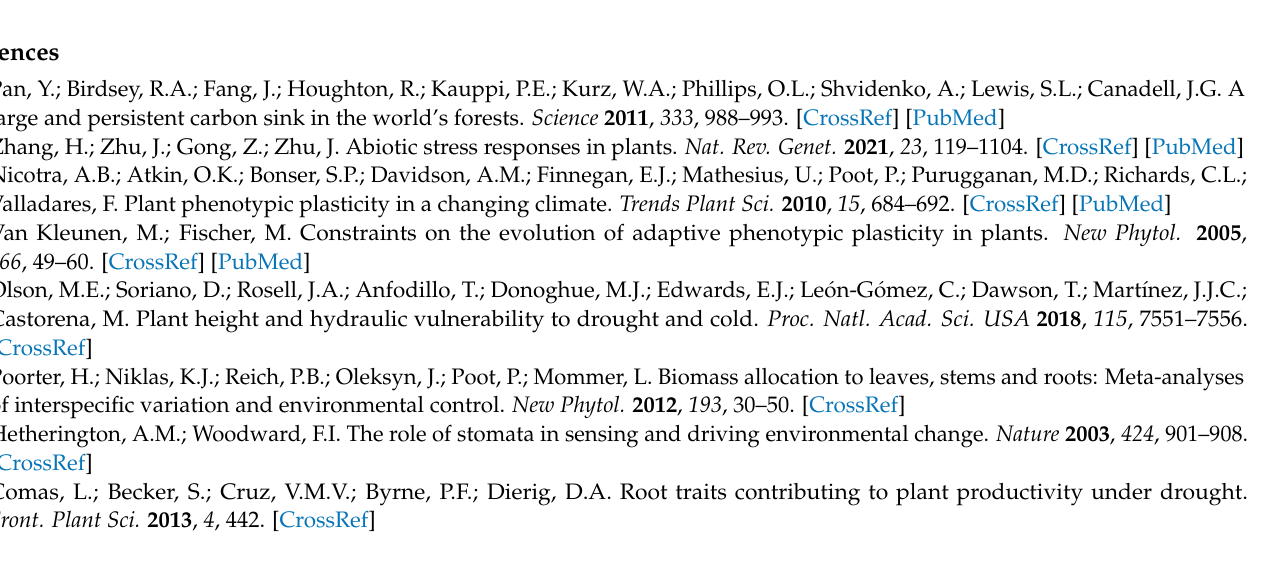
parameters. Table S2. The variable importance in projection (VIP) of parameters in OPLS-DA